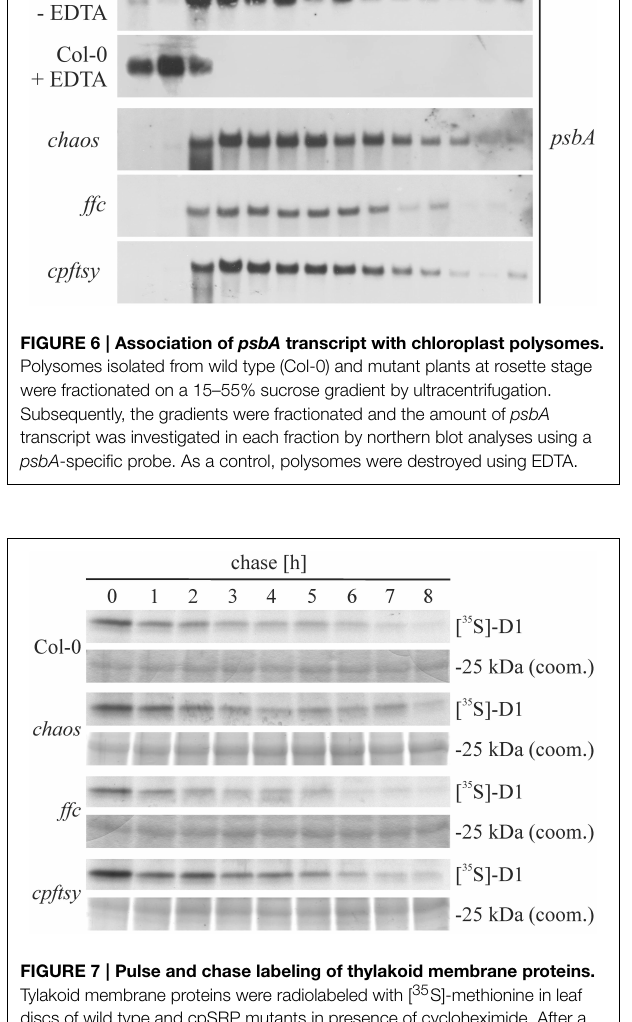
of cpSRP (Röhl and van Wijk, 2001). To compare the amount of membrane-bound translating ribosomes in wild type and the cpSRP mutants isolated thylakoid membranes were washed with buffers containing 60 mM or 1 M NaCl with or without 50